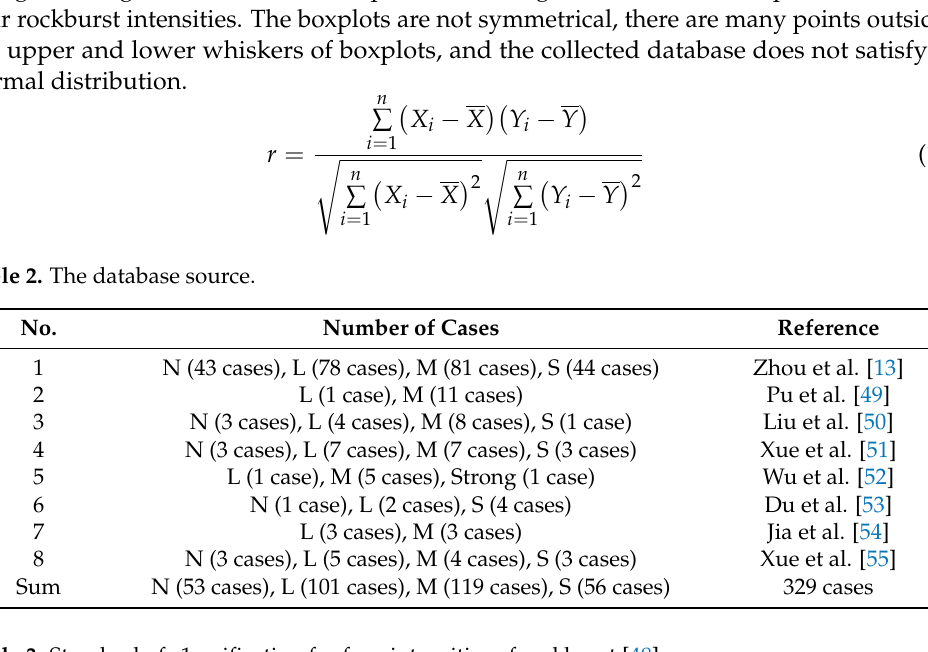
Table 3. Standard of c1assification for four intensities of rockburst [48].